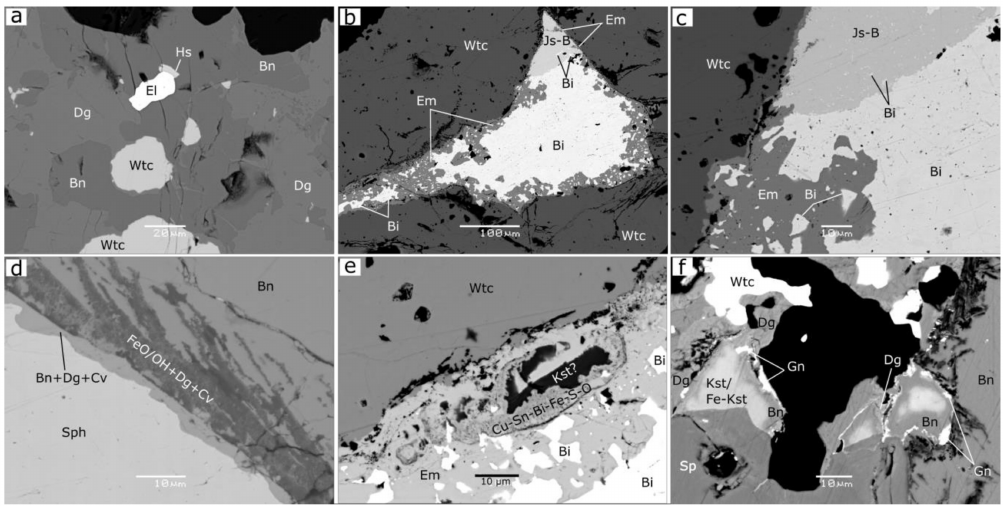
Figure 5. SEM-BSE images for electrum, Bi-, Zn- and Sn- minerals from the Antoniu North ( a ) and Blidar Contactorebodies( b–f ); ( a )electrumassociatedwithhessiteanddigenite; ( b )thevoidwithinwittichenite filled with native bismuth, emplectite, and jos é ite-B; ( c ) detail of ( b ) with native bismuth relicts hosted by emplectite and jos é ite-B; ( d ) bornite-sphalerite contact; ( e ) kësterite(?) and a mixture of secondary phases in association with emplectite at the native bismuth-wittichenite contact; ( f ) kësterite / ferrokësterite with galena rims associated with bornite, digenite, sphalerite, and wittichenite (from Andrii and T ă mas with permission from the editor). Abbreviations: Bi: native bismuth; Bn: bornite; Cv: covellite; Dg: digenite; El: electrum; Em: emplectite; FeO / OH: Fe oxides / hydroxides; Js-B: jos é ite-B; Kst?: possibly kësterite; Kst: kësterite; Fe-Kst: ferrokësterite; Sp: sphalerite; Wtc: wittichenite; Cu-Sn-Bi-Fe-S-O: the mixture of secondary mineral